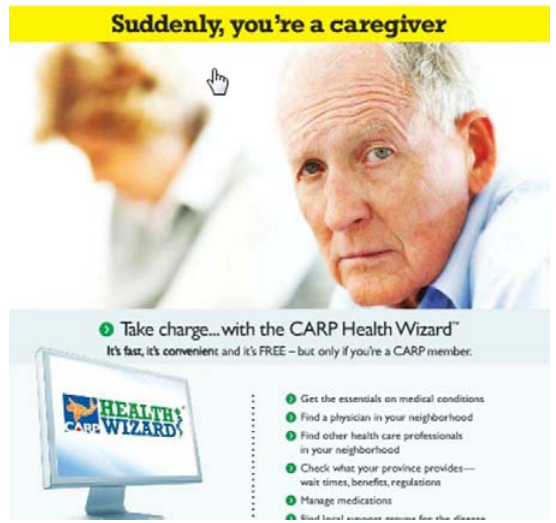
Zoomer Magazine 05/2012, p.